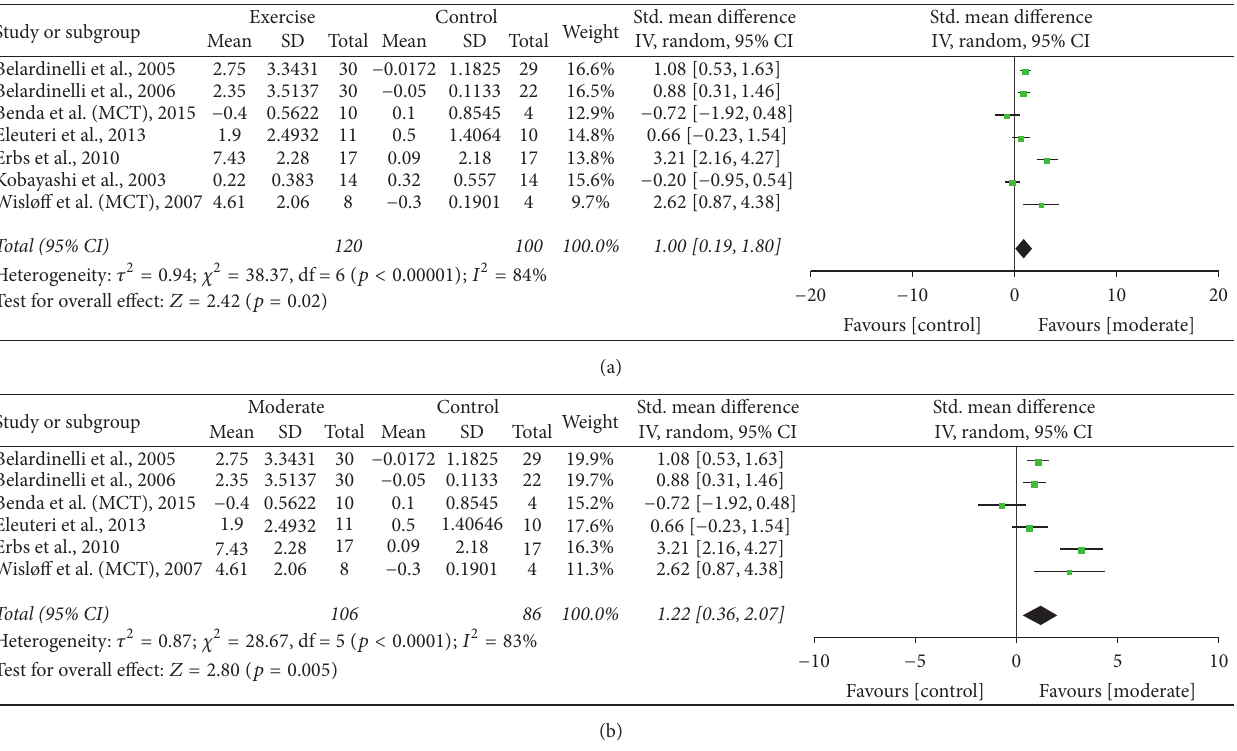
Figure 2: (a) FMD: moderate aerobic training versus control. (b) FMD: moderate aerobic training versus control (removal of Kobayashi study from moderate